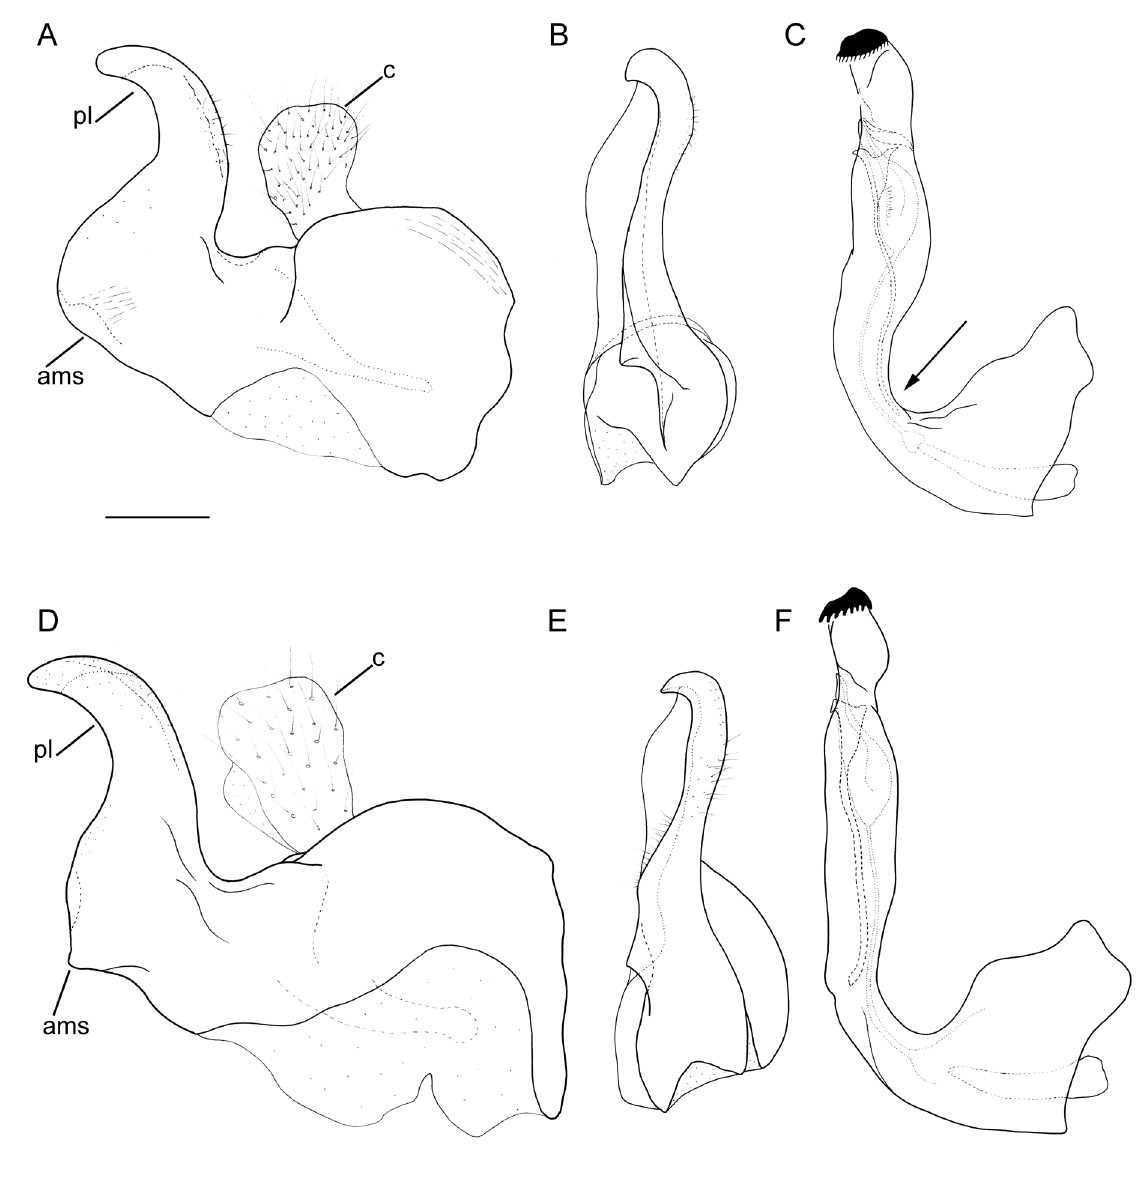
Fig. 7. Male genitalia. A–C . Merodon zebra Vujić & Radenković sp. nov., paratype (NBCN; FSUNS ID 05174). D–F . M. vittatus Vujić & Likov sp. nov., holotype (NBCN; FSUNS ID 04085). A, D . Epandrium, lateral view. B, E . Epandrium, ventral view. C, F . Hypandrium, lateral view. Abbreviations: ams = anterior margin of surstyle; c = cercus; pl = posterior lobe of surstyle. Scale bar = 0.25